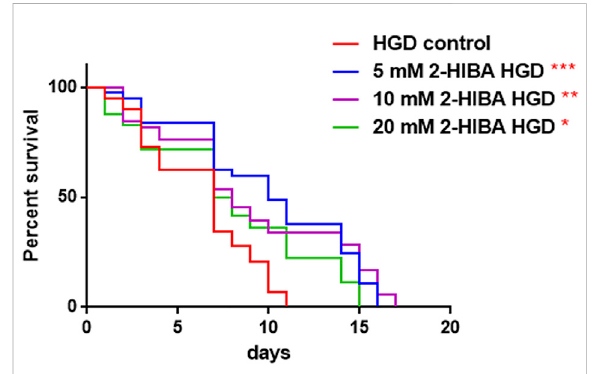
FIGURE 11 Effect of 2-HIBA on HGD wild-type worms (A) Kaplan – Mèier survival plot of HGD worms treated or not with 2-HIBA at different concentrations (control: untreated). n = 60 for each data point of single experiments. Bars represent the mean of three independent experiments. Asterisks indicate the p -values (log- rank test) with respect to the untreated control (* p < 0.05, ** p < 0.01, *** p < 0.001).